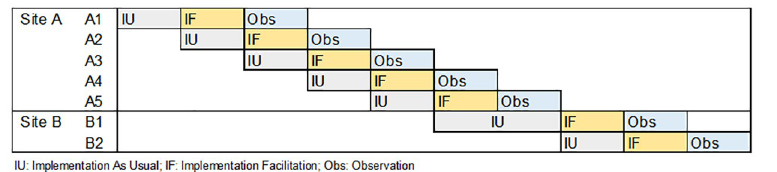
Fig 1. Modified stepped-wedge trial